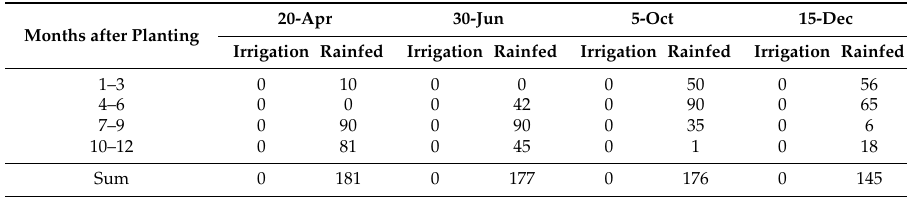
Table 2. The number of days the soil water potential fell below the critical level ( − 30 KPa) for cassava cv. Rayong 9 under irrigated and rainfed conditions using four planting